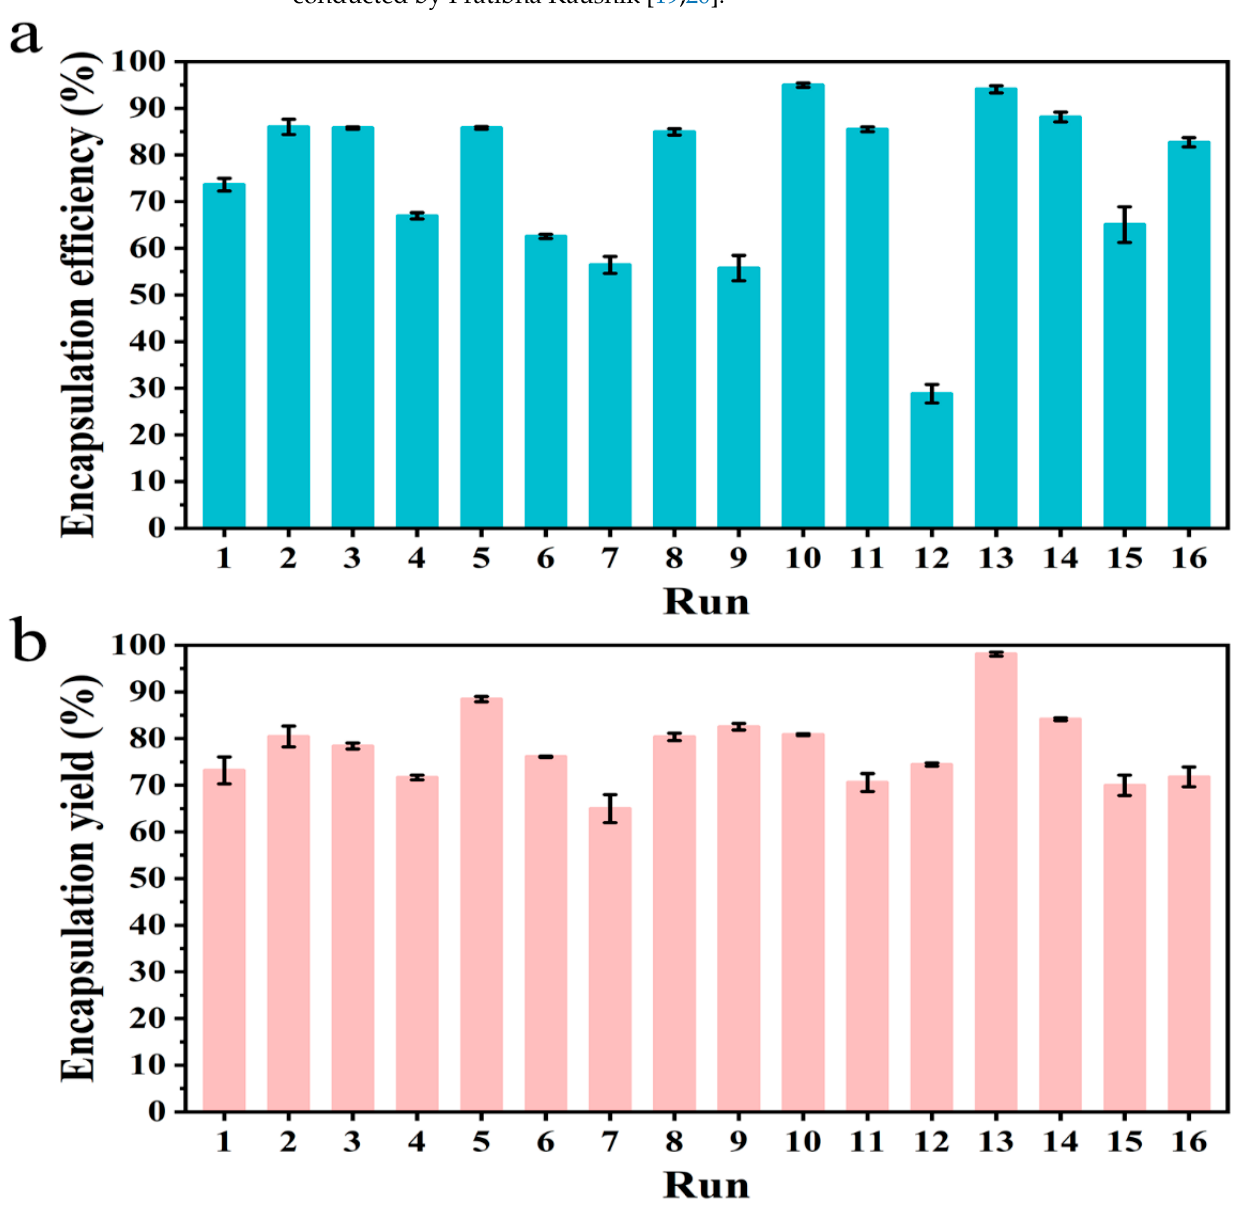
Figure 1. The encapsulation efficiencies ( a ) and encapsulation yields ( b ) of the flaxseed oil powders from the orthogonal L16 (4) 4 experiments.